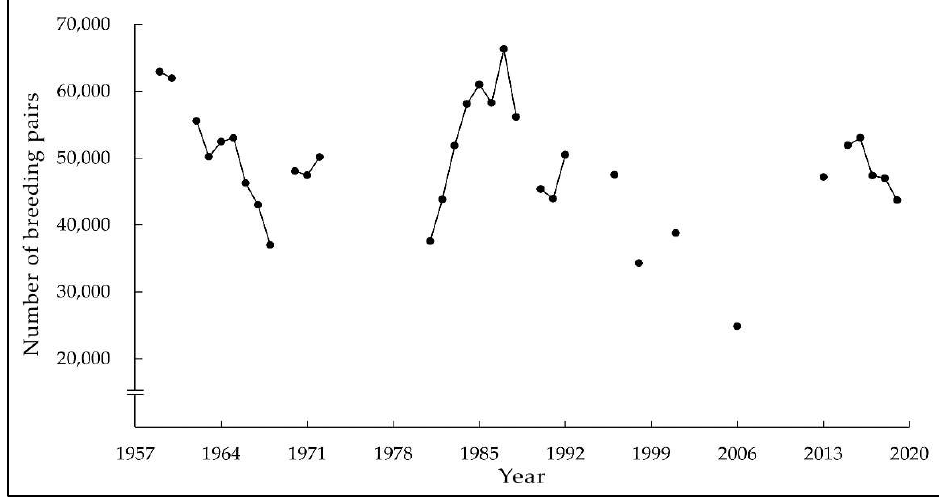
Figure 1. Population changes of Adélie penguin breeding pairs at Cape Hallett